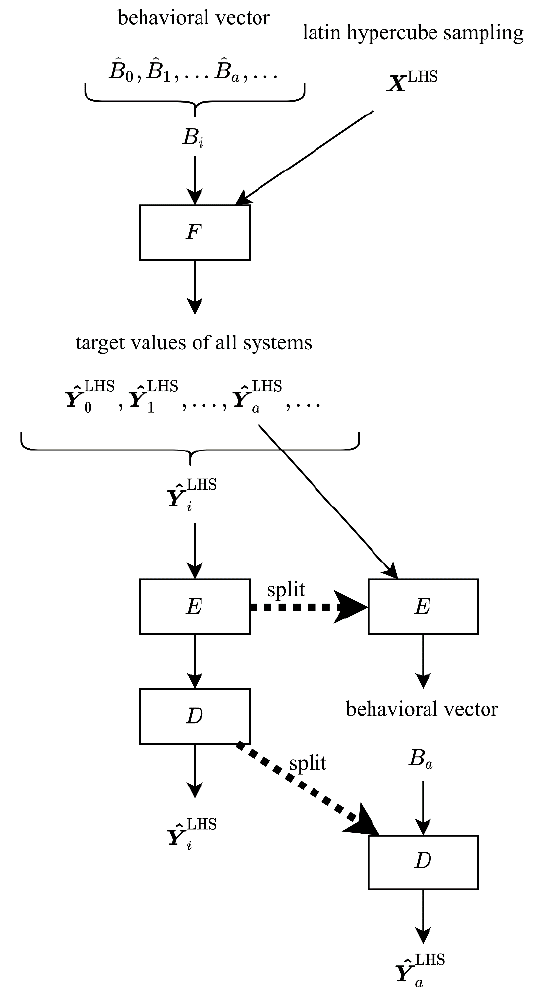
Figure 6. Usage of the encoder–decoder ED. The behavioral vector B is defined from the output of the encoder from Latin hypercube (LHC) sampled target values ˆ Y LHC .